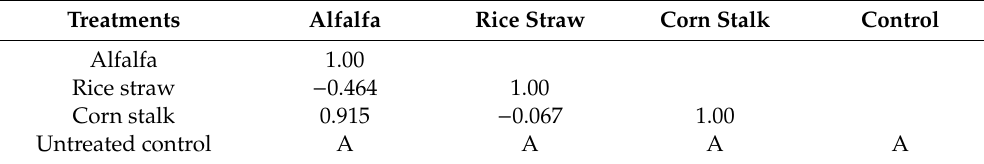
Table 4. In-vitro digestibility on digesta; Pearson correlation.